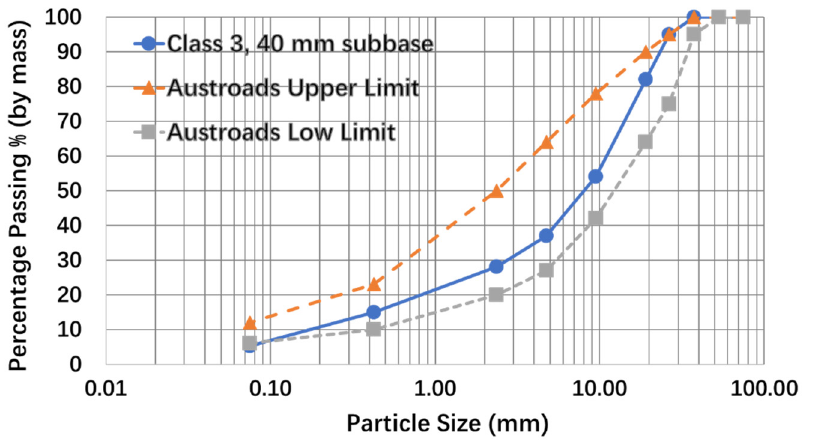
Figure 2. Particle size distribution of the tested aggregates.